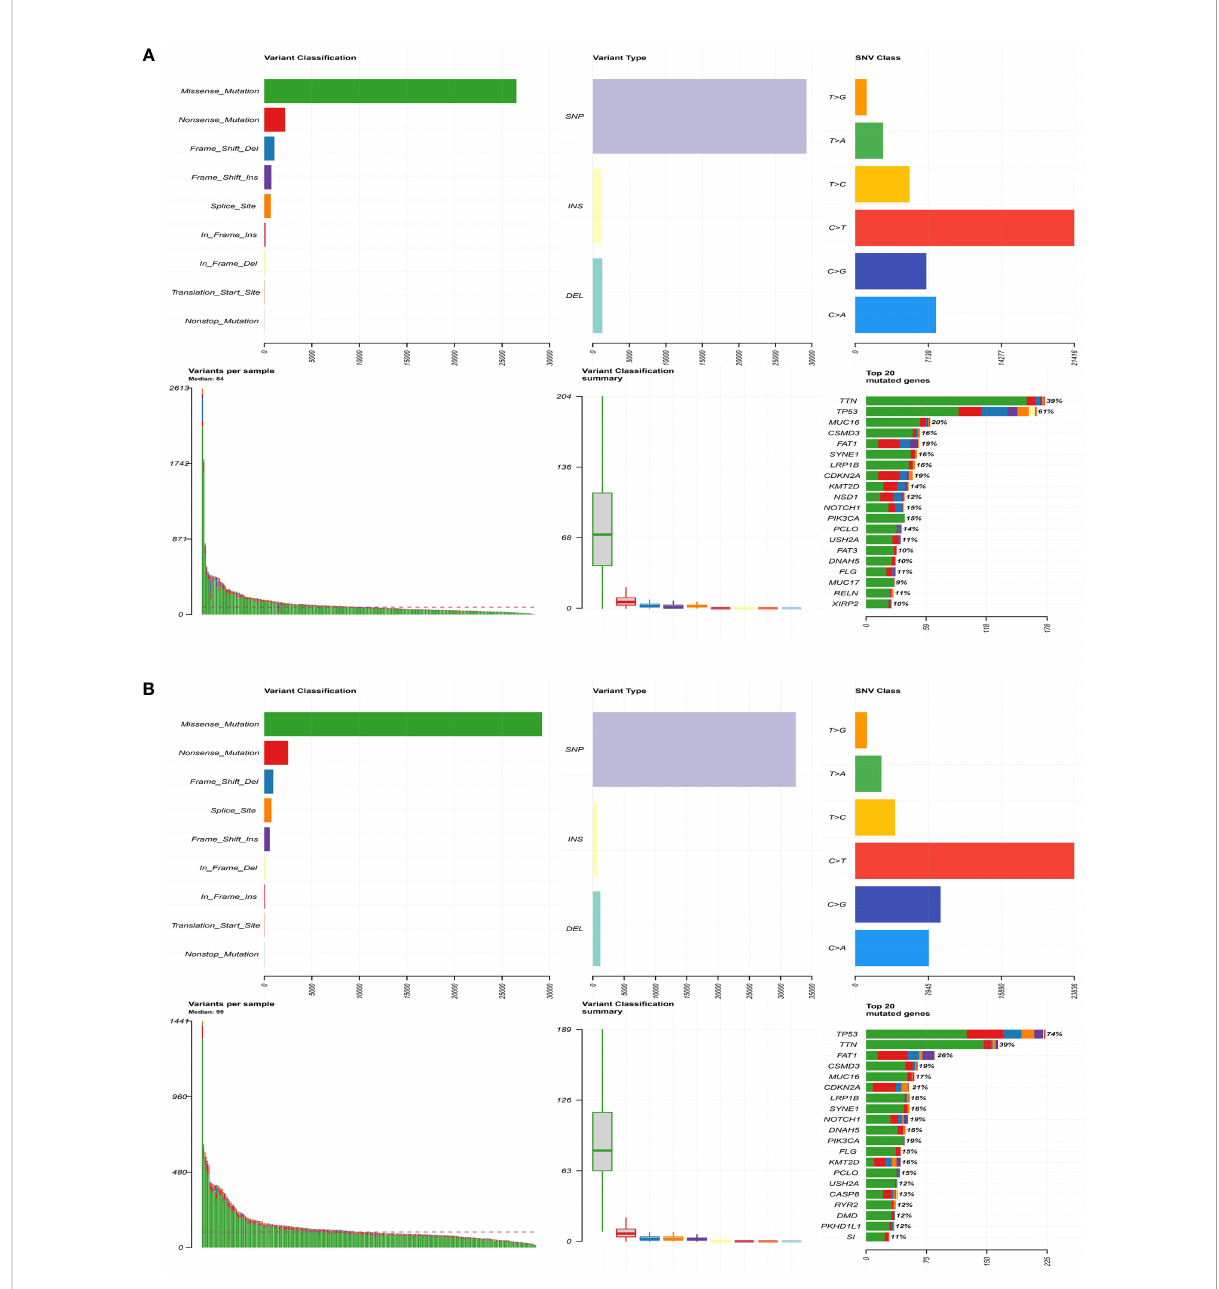
FIGURE 6 Comparison of genetic mutations in the high- and low-risk group. (A) The top 20 most frequently mutated genes in the low-risk group. (B) The top 20 most frequently mutated genes in the high-risk